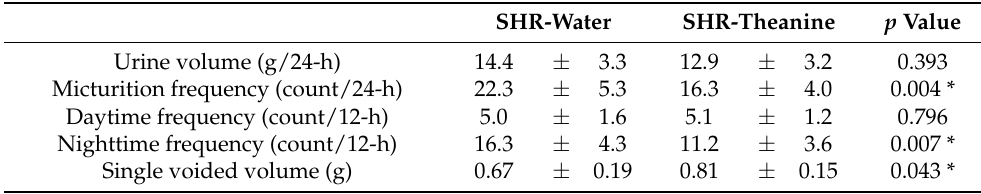
Table 2. Comparison of each parameter in 24 h metabolic cage experiments. * Statistical significance at the p < 0.05 level.